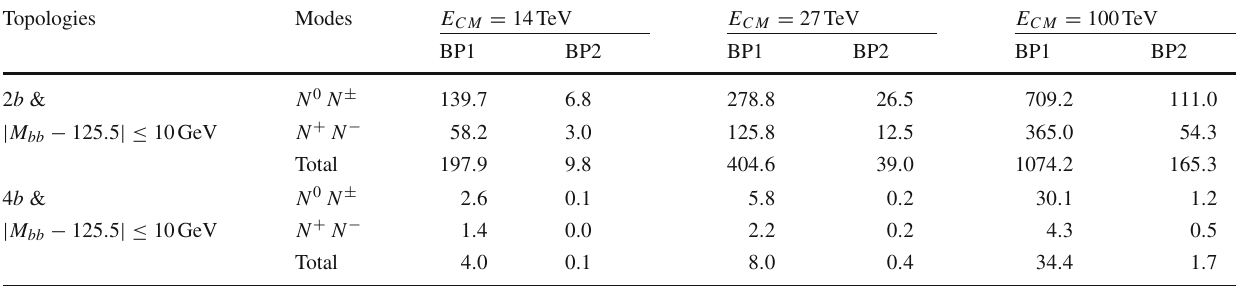
Table 8 The number of events for single Higgs boson and di-Higgs boson mass peaks after the window cuts around the peak of the invari- ant mass distributions at the LHC/FCC at the centre of mass energies